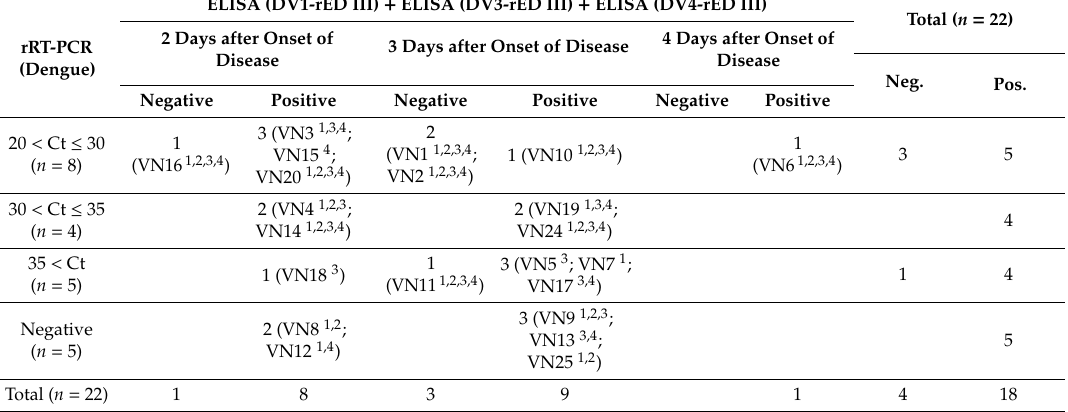
Table 4. Diagnostic performance of DV1-rED III-linked ELISA at di ff erent times after the onset of disease. ELISA (DV1-rED III) + ELISA (DV3-rED III) + ELISA (DV4-rED III) Total ( n = 22) 2 Days after Onset of 3 Days after Onset of Disease 4 Days after Onset of Disease Disease Neg. Pos. Negative Positive Negative Positive Negative